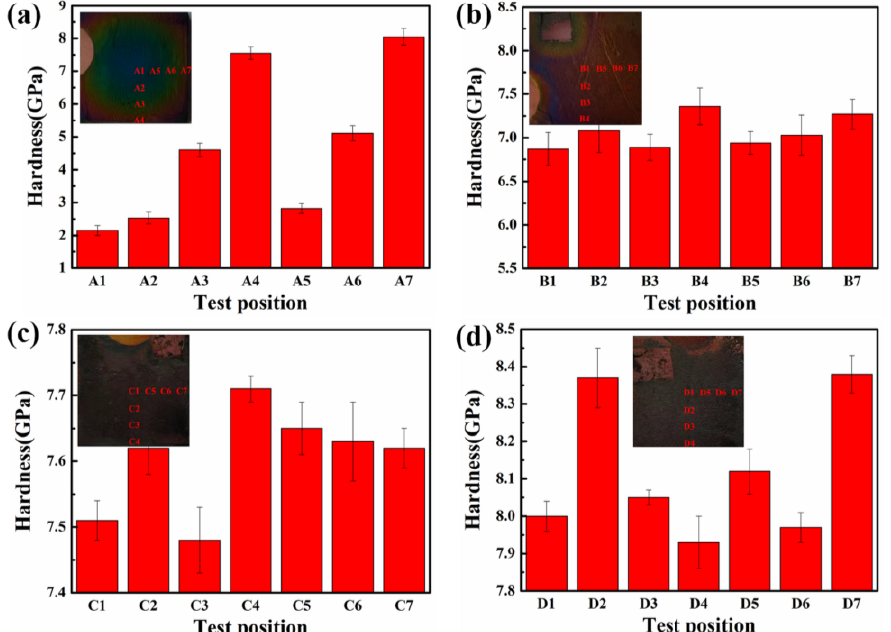
Figure 6. Mechanical hardness of ( a ) the film deposited on Ti/PMMA without conductive material at the bias of 950 V, and DLC films deposited on Ti/PMMA at a different substrate bias of ( b ) 550 V, ( c ) 750 V, and ( d ) 950 V with conductive material.